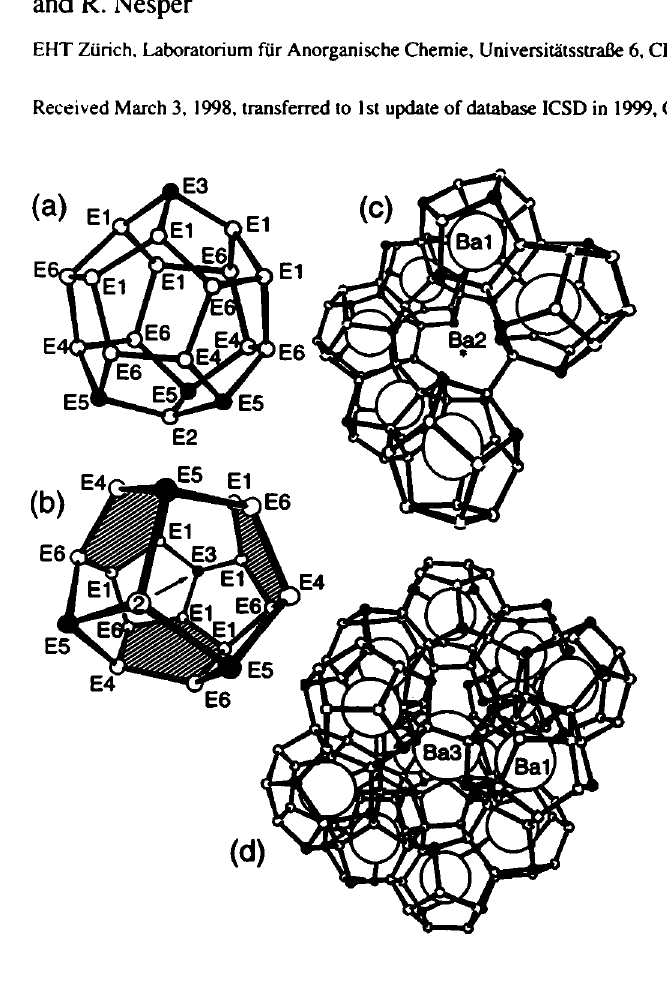
Table 1. Parameters used for the X-ray data collection